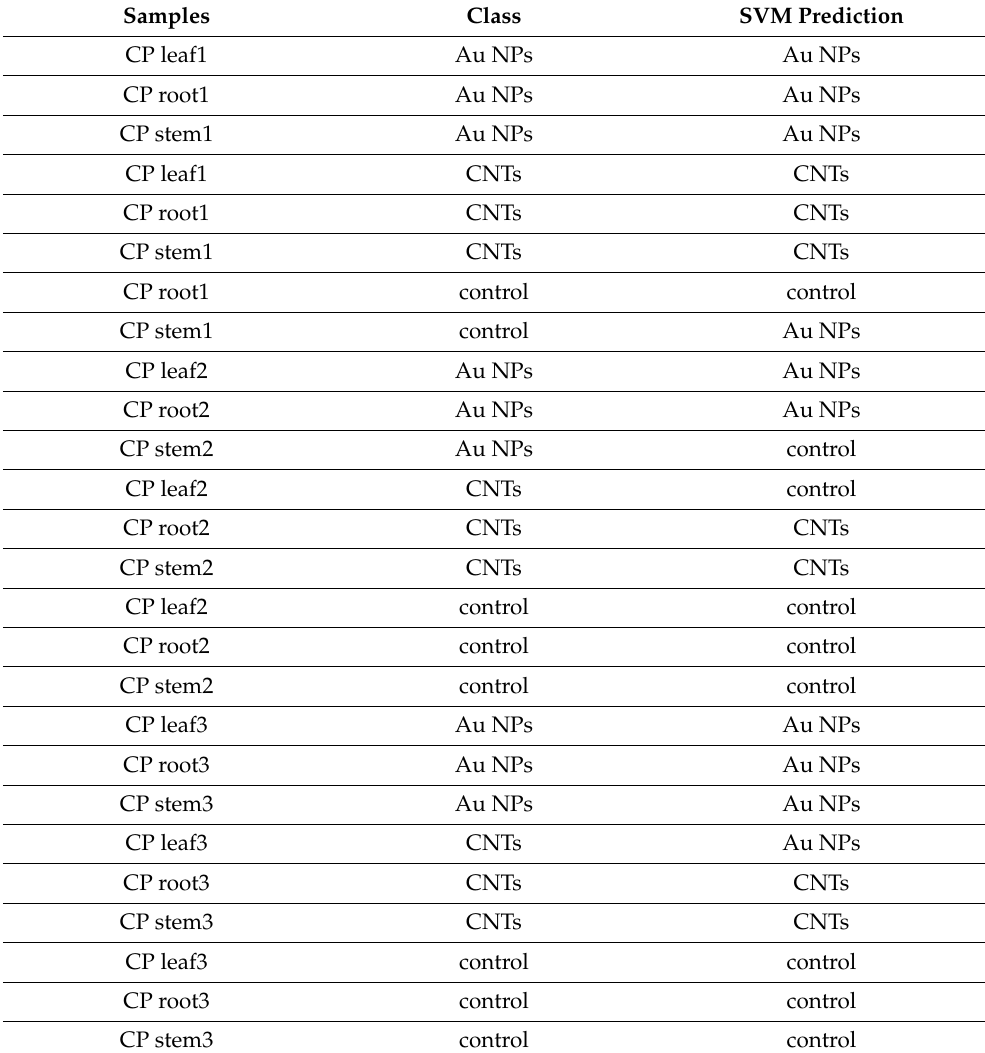
Table 2. SVM classification for ATR-FTIR spectral data of C. arietinum samples (all plant parts combined for the analysis) grown at 3 conditions (Class): (1) Au NPs (Au NPs), (2) carbon nanotubes (CNTs) and (3) control ground (control). Correct SVM prediction is marked by the bold green font (green is correct prediction and red is wrong prediction).